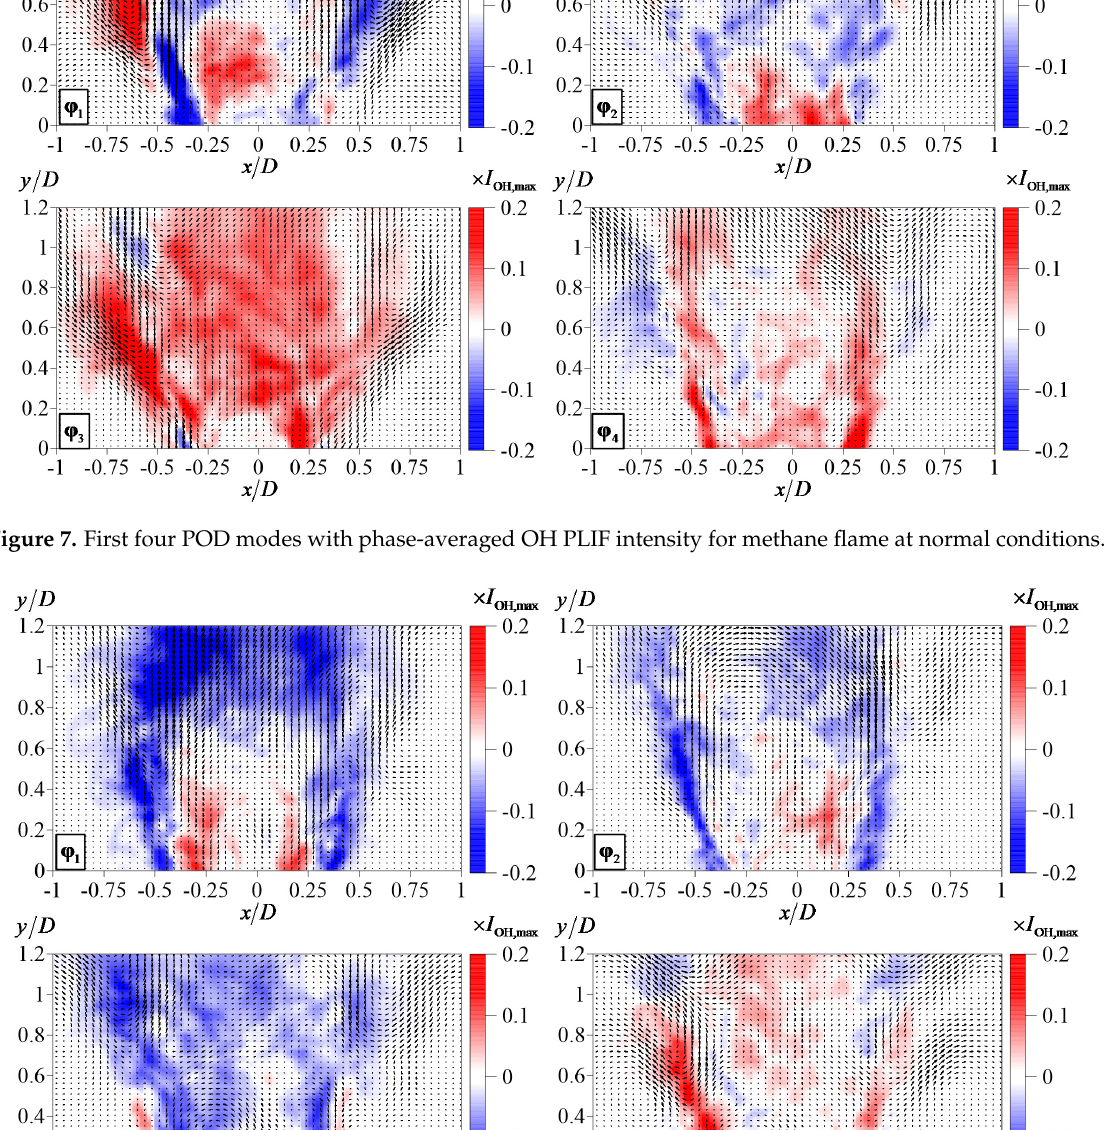
Figure 8. First four POD modes with phase-averaged OH PLIF intensity for methane flame at elevated conditions.